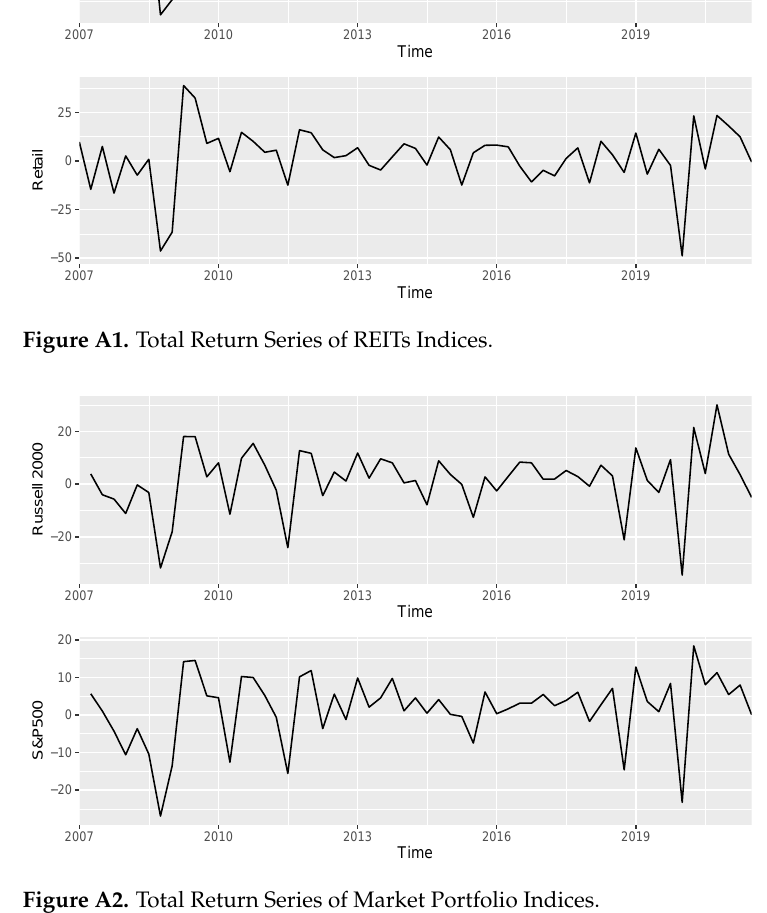
Figure A2. Total Return Series of Market Portfolio Indices.